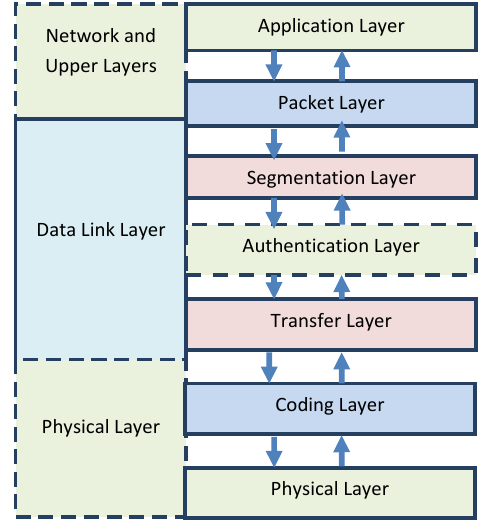
Figure 4. CCSDS Layered Architecture